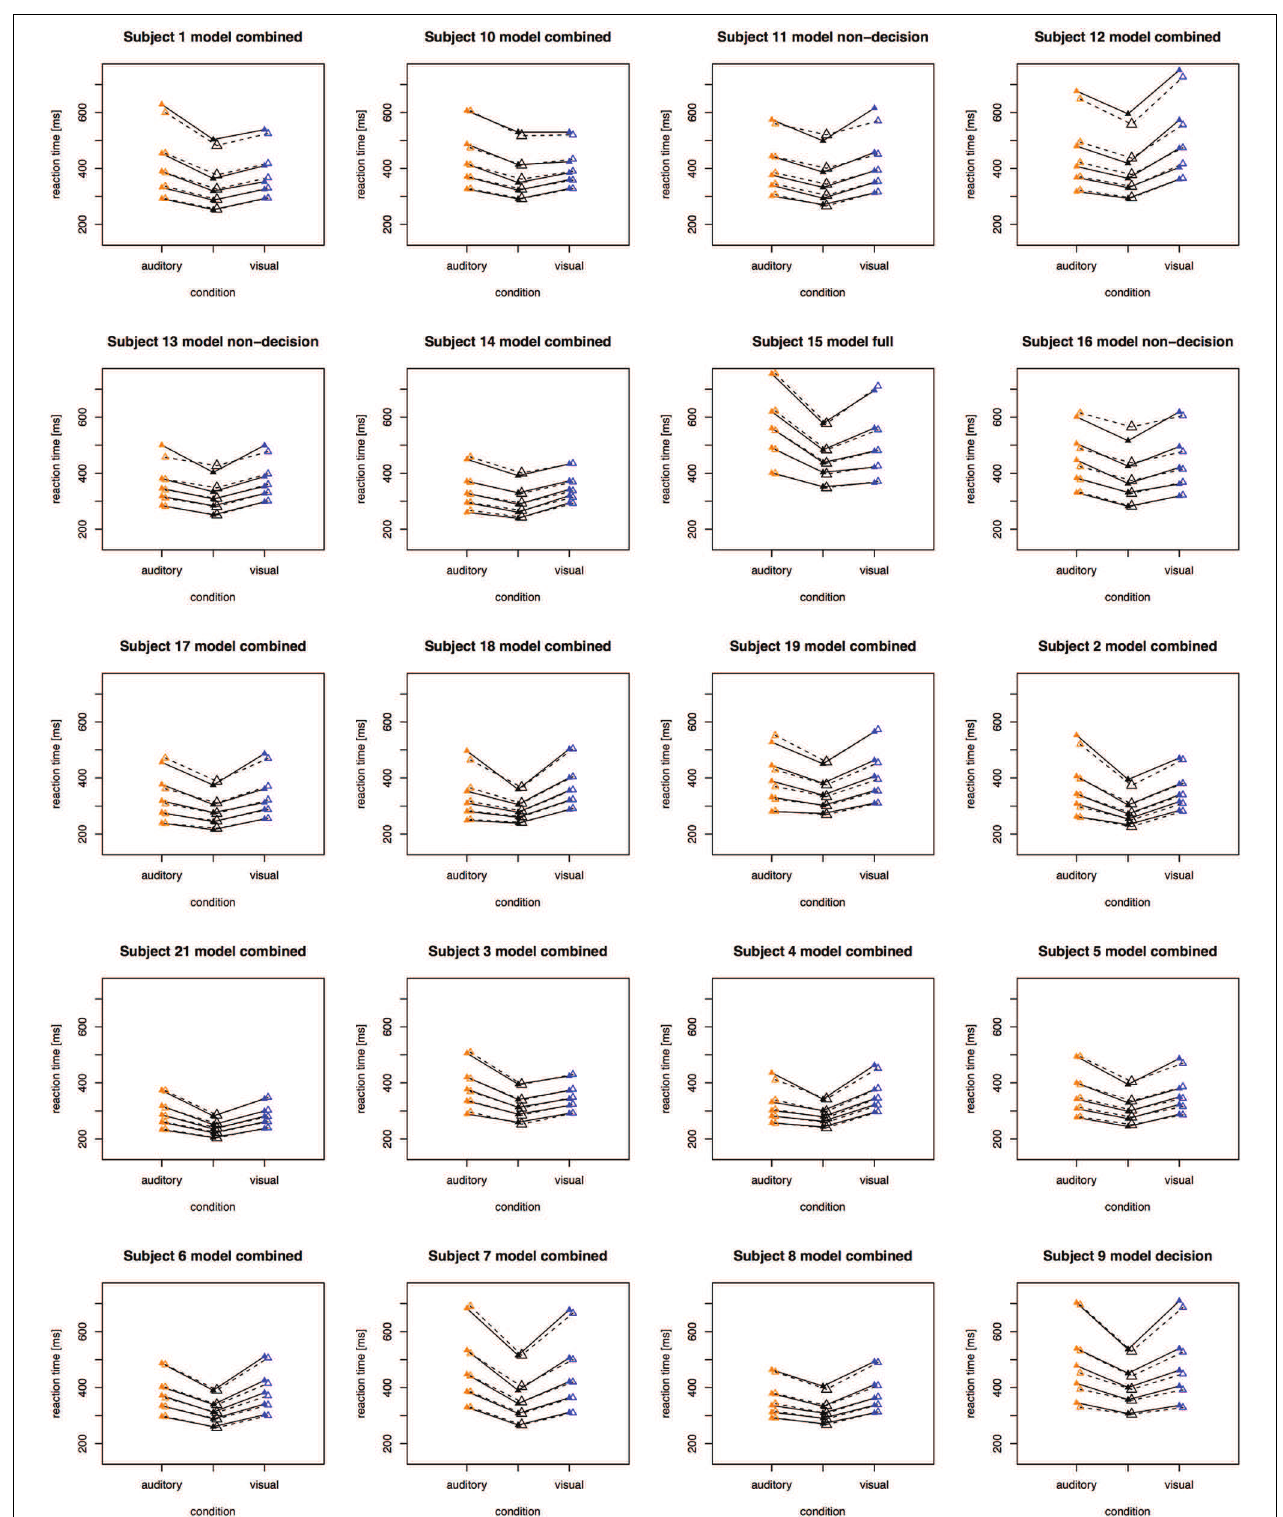
FIGURE 5 | Quantile reaction times. Quantile reaction times for single subjects in Experiment 2. The type of best fitting model is indicated in the each figure heading.